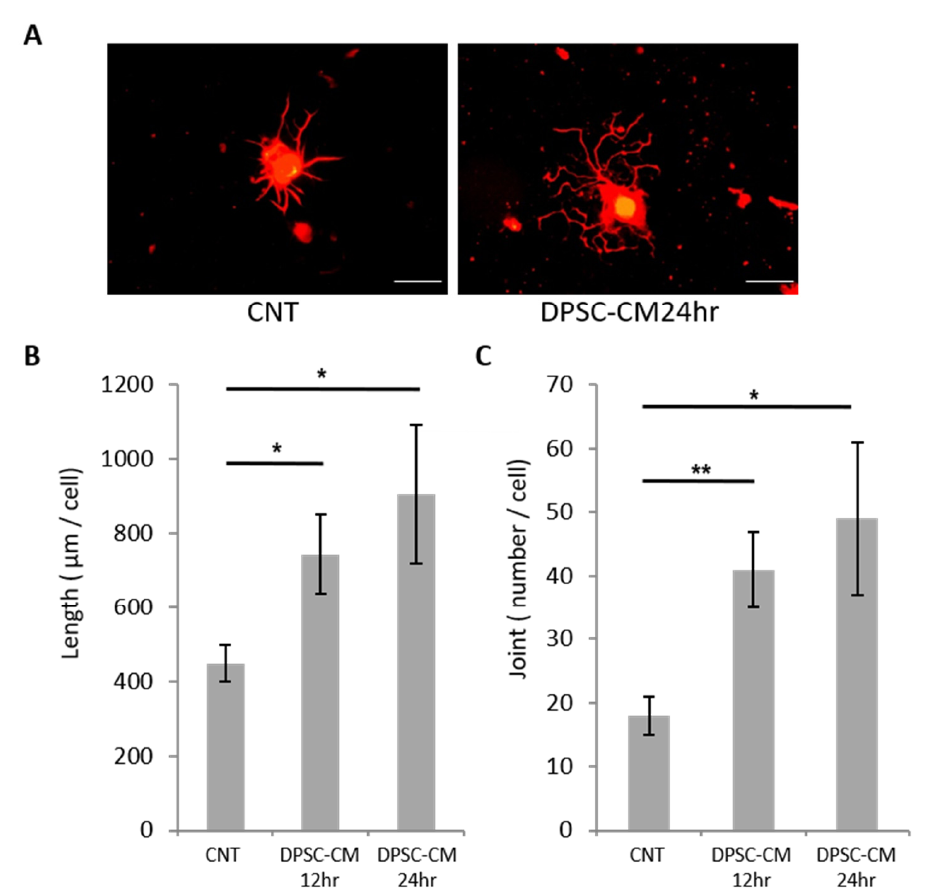
Figure 2. Neurite outgrowth of DRG neurons with hDPSC-CM. ( A ) Representative fluorescence micrograph of DRG neurons stained for neurofilaments in culture with hDPSC-CM after 24 h. Scale bar = 50 µm. Measurements of total neurite length ( B ) and joint number of neurites ( C ). The results are expressed as the mean ± SEM ( n = 11). * p < 0.05, ** p < 0.01. CNT: control, DPSC-CM: DPSC-conditioned medium .